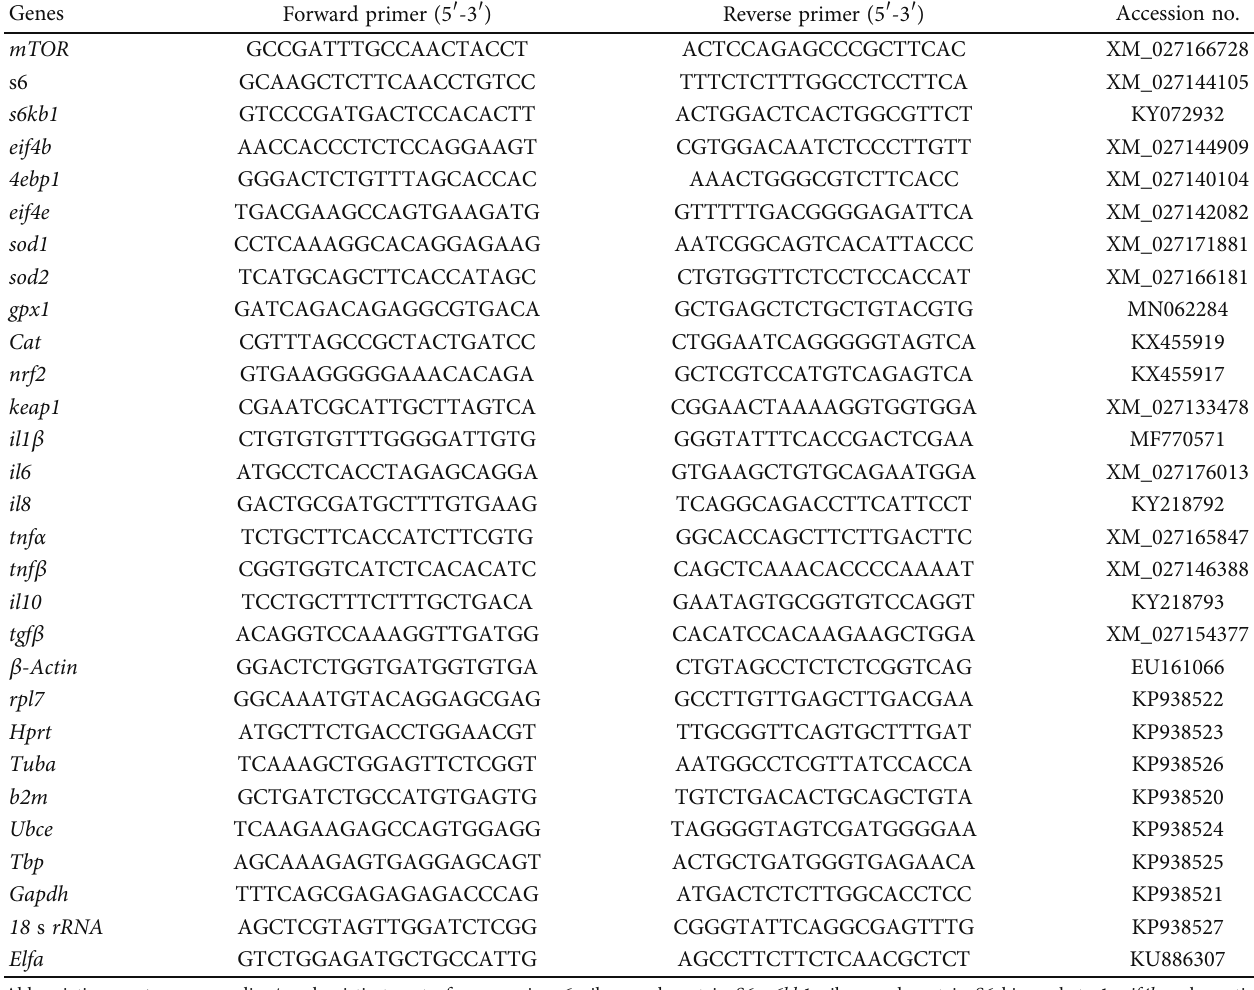
Table 2: Primers used for quantitative real-time PCR analysis. Genes Forward primer (5 ′ -3 ′ ) Reverse primer (5 ′ -3 ′ ) Accession